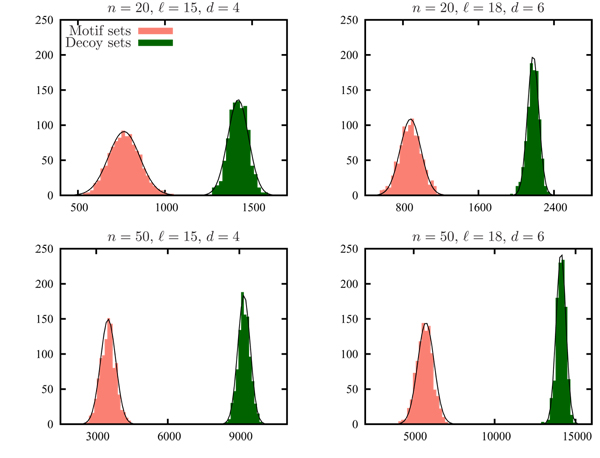
Weight distribution histograms. Histograms showing weight distributions for motif sets and decoy sets. Normal distributions fitted to the data are shown to indicate that the weight distributions are approximately normal.